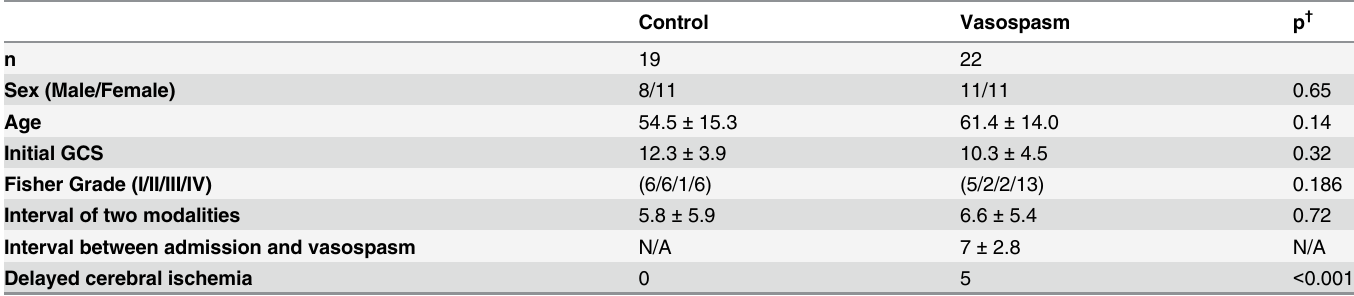
The clinical symptoms and signs for all forty-one patients are summarized in Table 1. The mean time interval between the CTP and DSA scanning starts was 6.1 hours. The mean time interval between admission and vasospasm development was 7 ± 2.8 days. All of the treatments were smoothly. There were not significantly more subjects with higher Fisher grades in the vasospasm group than in the control group ( p = 0.186). There was a significantly higher inci- dence of delayed cerebral ischemia in the vasospasm group ( p < 0.001). The ICCs for DSA- based TTP measurements between the two readers ranged from 0.92 to 0.98, and the ICCs for the CTP-based TTP measurements ranged from 0.85 to 0.99. The consistency of venous ROI placement and time measurement was not inferior to that of the arterial ROI in either the DSA or the CTP. Although there was less consistency for the DSA-based RA2 (ICC = 0.92) and CTP-based LM2 (ICC = 0.85) measurements, CCT measurement showed good consistency across the DSA- and CTP-based methods, with ICCs ranging from 0.96 to 0.98 (Table 2). Table 1. Distribution of Patient Characteristics between control and vasospasm